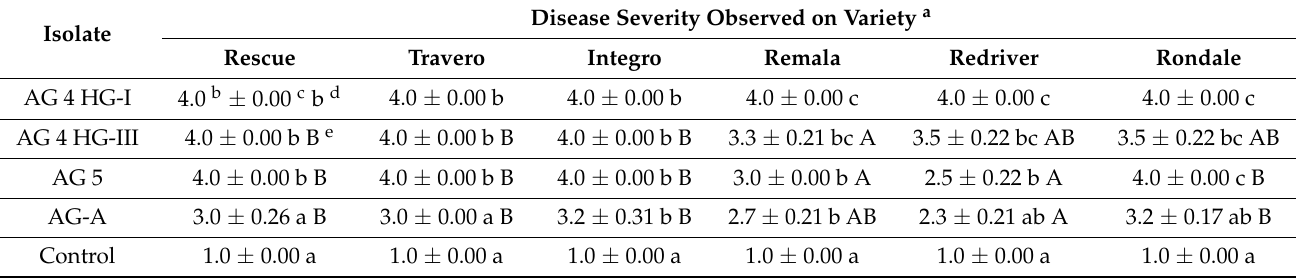
Table 4. Host response of some commercial red cabbage cultivars to isolates belonging to different anastomosis groups (AGs) of Rhizoctonia spp. in vivo